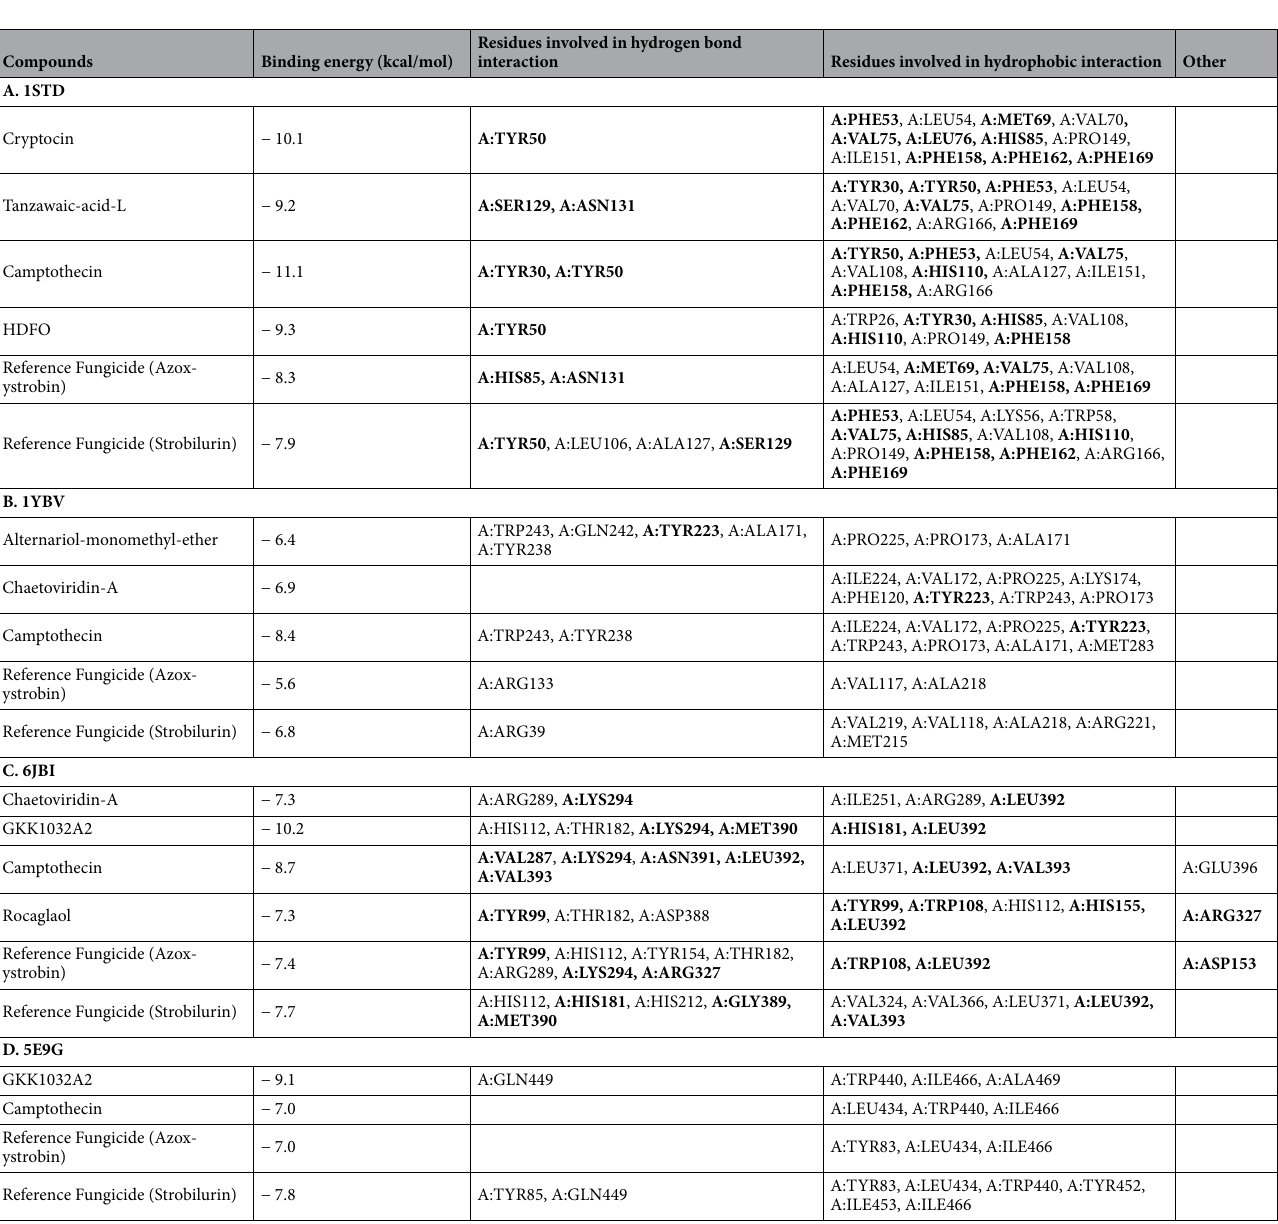
Table 1. Summary of top-ranked compounds screened against scytalone dehydratase (1STD), trihydroxynaphthalene reductase (1YBV), trehalose-6-phosphate synthase 1 or Tps1 (6JBI) and isocitrate lyase enzyme (5E9G) with their respective binding energy and interacting amino acid residues. *Active site amino acids are